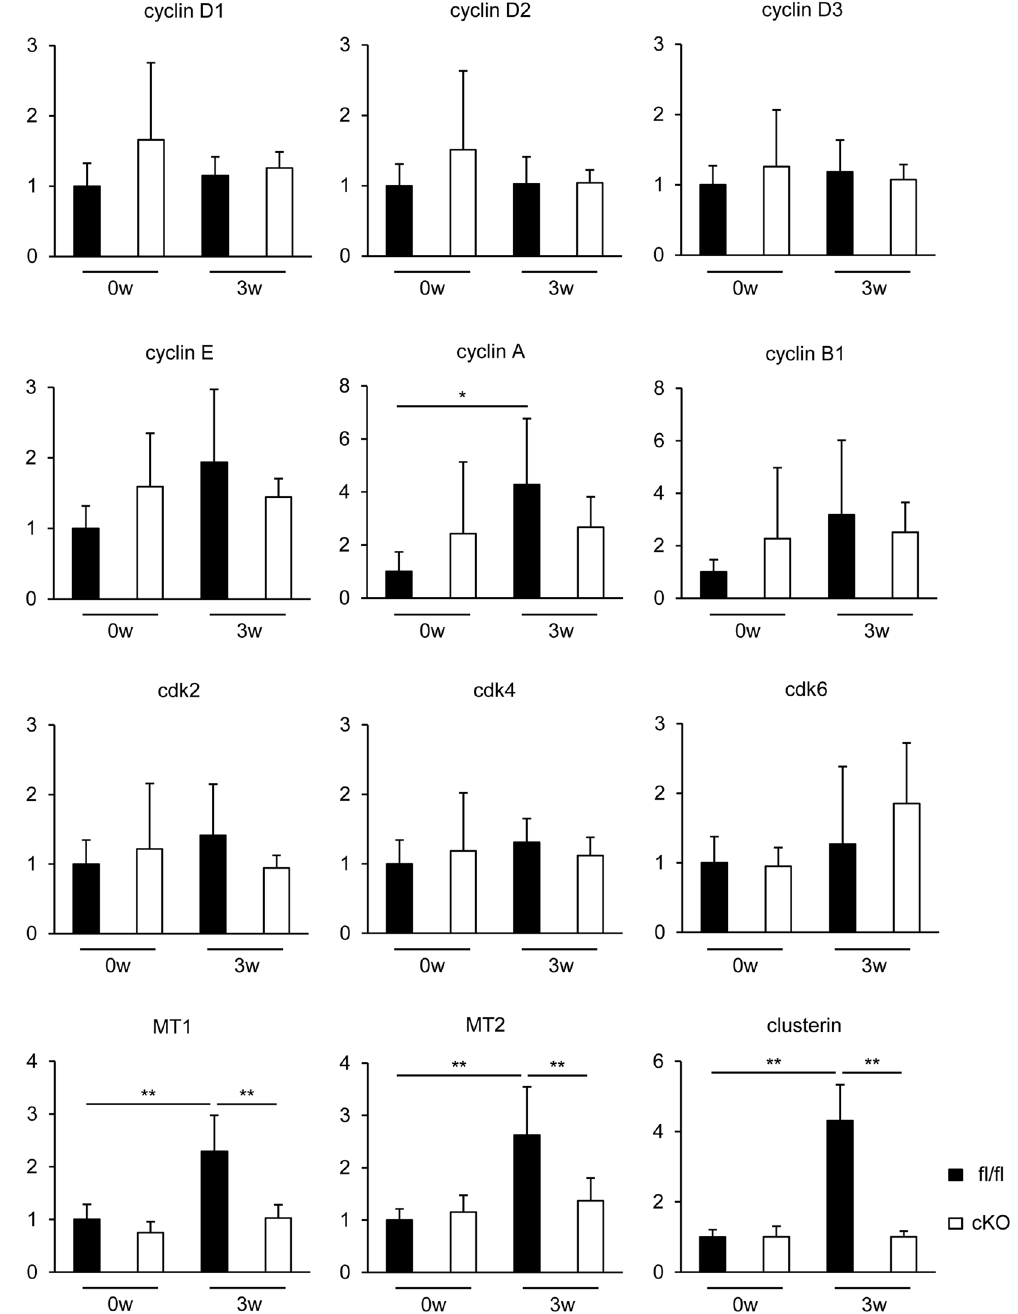
Figure 7. The expression of regeneration-related genes, metallothioneins and clusterin , was downregulated in STAT3cKO cardiomyocytes. Cardiomyocytes were isolated from STAT3fl/fl and STAT3cKO hearts at EAM0w and EAM3w. Cyclin D1, cyclin D2, cyclin D3, cyclin E, cyclin A, cyclin B1, cdk2, cdk4, cdk6, MT1, MT2 and clusterin mRNA expression was quantified by quantitative RT-PCR. The expression of these genes was normalized to that of gapdh and shown as fold increase relative to fl/fl 0w. n = 6 mice for fl/fl 0w and cKO 0w; 8 mice for fl/fl 3w and cKO 3w. Two-way factorial ANOVA. * P < 0.05, ** P < 0.01. Data are shown as mean ±